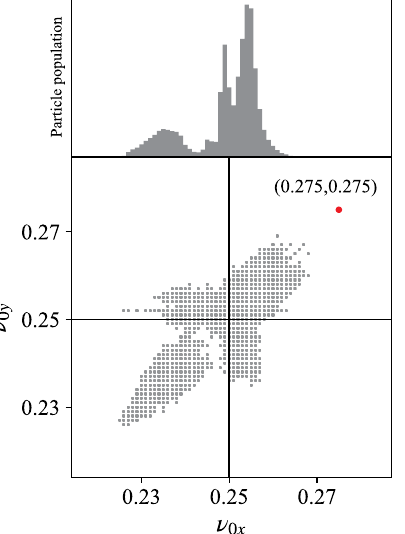
FIG. 9. Incoherent tune spread of a Gaussian beam after the rapid initial emittance growth due to the fourth-order resonance was nearly settled. The operating point is set at ν 0 x ¼ ν 0 y ¼ 0 . 275 (red dot) where non-negligible emittance growth occurs. The rms tune depression is adjusted initially to η ¼ 0 . 9 .